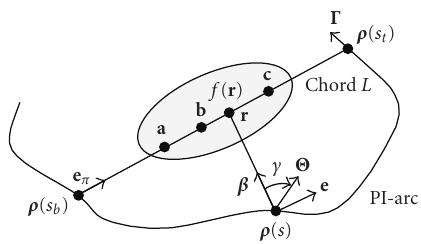
Figure 1: Basic setting for exact 3D interior reconstruction.